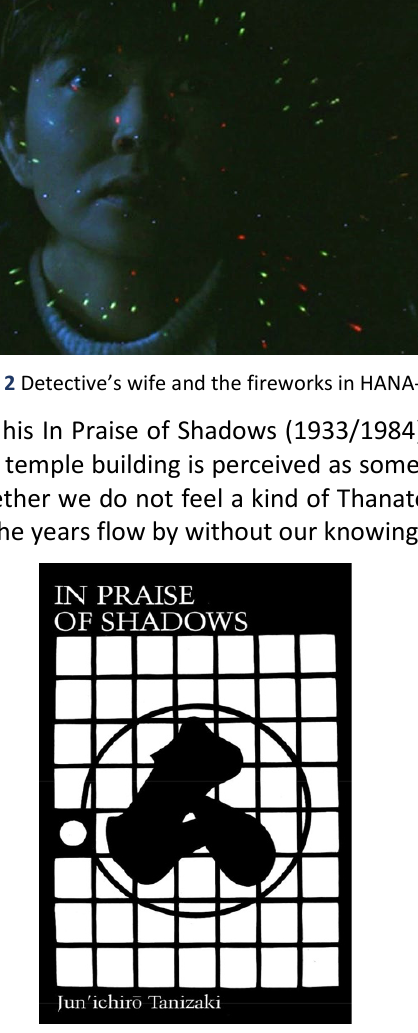
Figure 3 In Praise of Shadows, Junichio Tanizaki